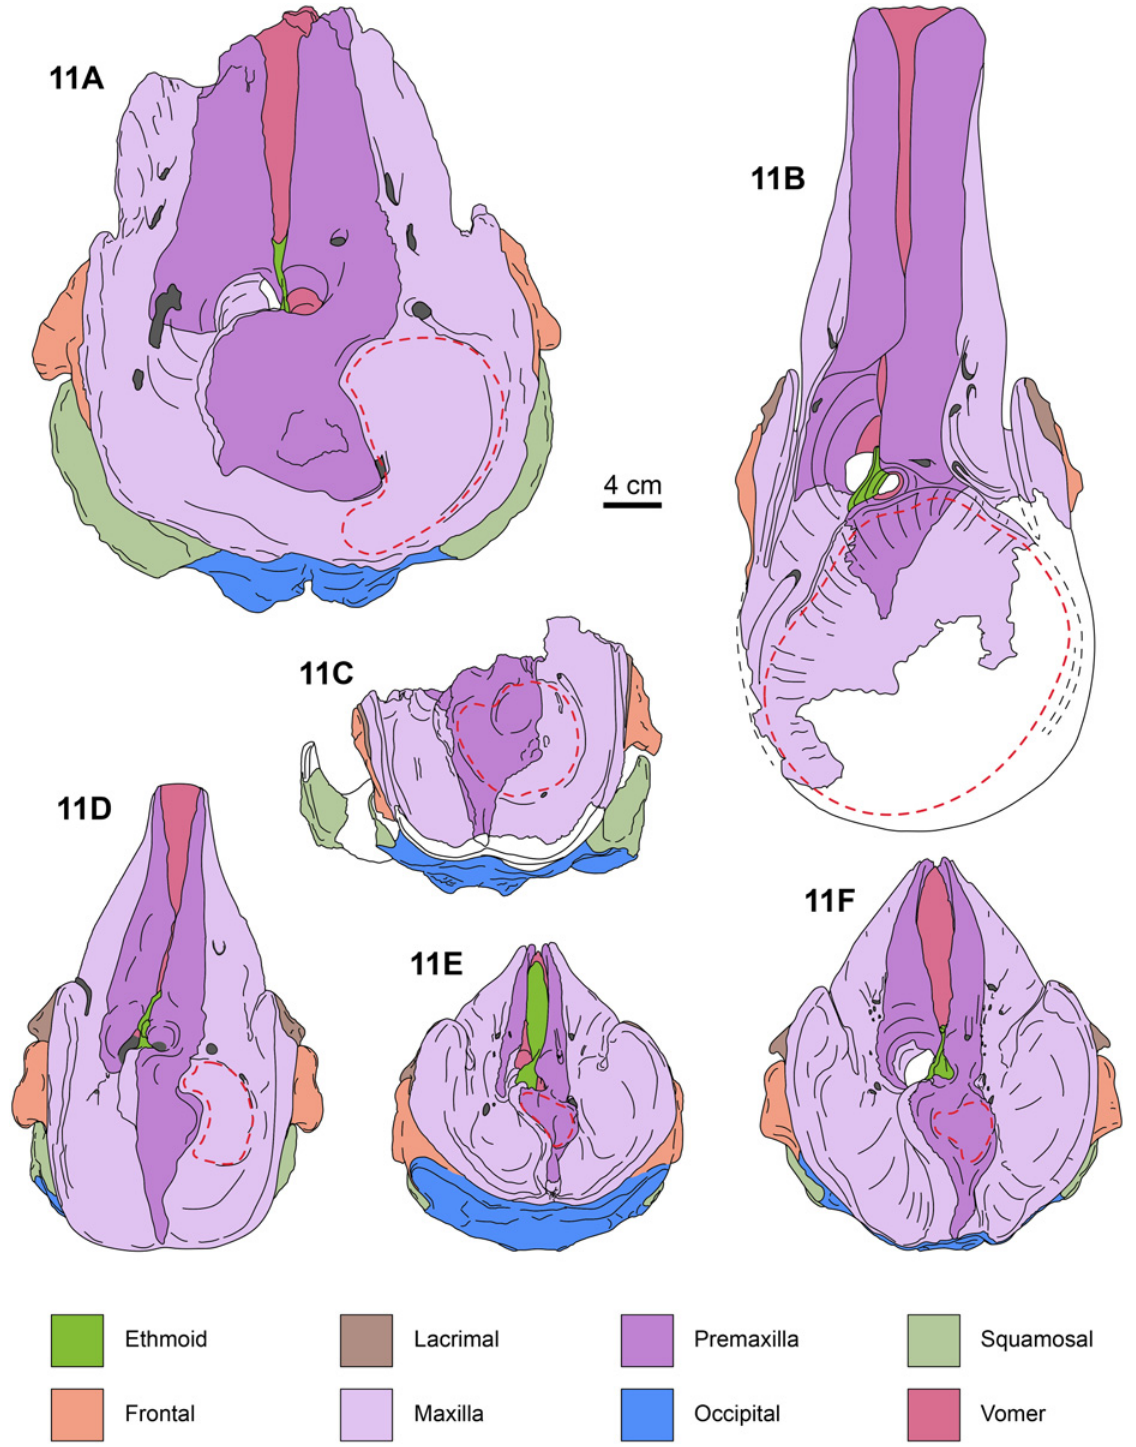
Fig 11. Dorsal views of kogiid skulls. Aprixokogia kelloggi (USNM 187015), 11A, Scaphokogia cochlearis (MNHN PPI 229), 11B, Praekogia cedrosensis (UCMP 315229), 11C, Nanokogia isthmia gen. et sp. nov. (based on UF 280000 and 273554), 11D, Kogia sima (LACM 47142), 11E, and, K . breviceps (LACM 95745), 11F. Each bone is color-coded for ease of comparison. Red dashed lines denote the extent of the supracranial/premaxillary fossa. Areas in white are not preserved and have been reconstructed with plaster on the specimens. Illustration of S . cochlearis modified from Muizon [8]; all other illustrations based on the specimens